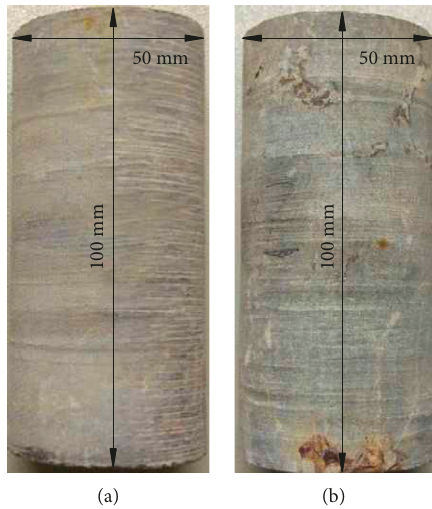
Figure 4: Intact rock sample (a) and rock mass sample